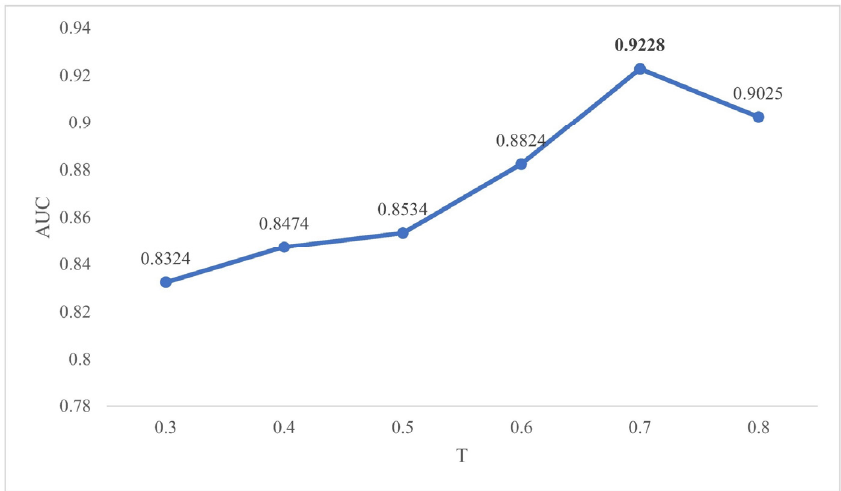
Figure 3. The AUC values of FCV with T being 0.3–0.8.